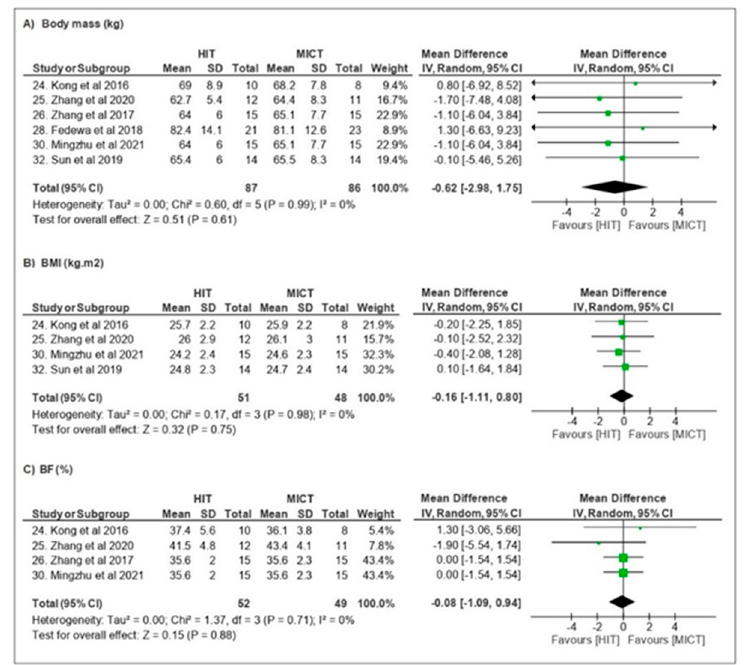
Figure 2. Forest plot of the effects of HIT vs. MICT intervention on outcomes: ( A ) body mass, ( B ) body mass index (BMI) and ( C ) percentage of body fat (BF%); HIT: high-intensity interval training; MICT: moderate intensity continuous training; IV—inverse of the variance; CI: confidence interval; SD: standard deviation.